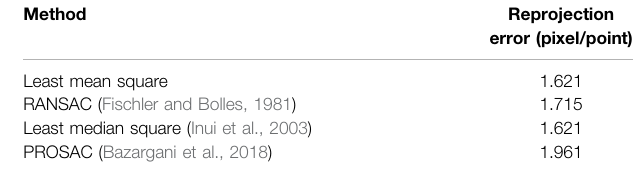
TABLE 1 | Optimization methods and the reprojection